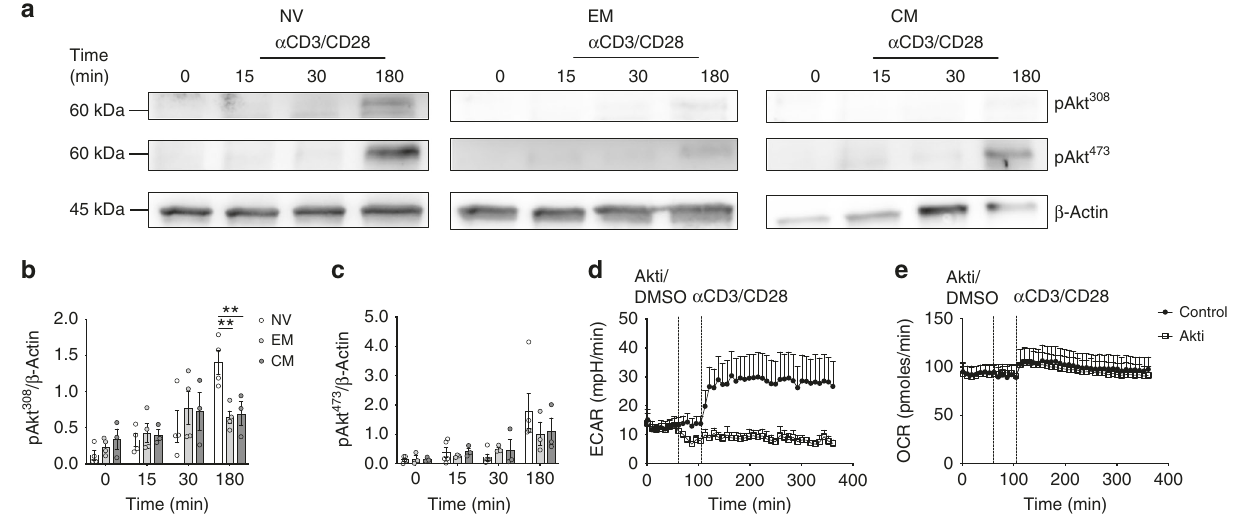
Fig. 4 Early T-cell activation requires Akt phosphorylation. a Immunoblot for pAkt Thr308 and Ser473 and β -actin in NV, EM and CM T-cells following 0, 15, 30 and 180 min of activation with anti-CD3/CD28. Densitometry of pAkt Thr308 ( b ) and pAkt Ser473 ( c ) for NV, EM and CM T-cells normalised to β - actin. ECAR ( d ) and OCR ( e ) in NV CD4 + T-cell upon treatment with either 10 μ M Akt1/2 kinase inhibitor or vehicle control (DMSO) and anti-CD3/CD28 at the times indicated. Data are representative ( a – c ) of 3 – 5 experiments with one representative immunoblot sample of 3 – 5 is shown, ( d , e ) three experiments. Statistical analysis was performed using a nonmatching two-way ANOVA with Sidak ’ s multiple comparison test ( b , c ). Data are expressed as mean ± SEM; ** p ≤ (Fig. 6d). The presence of the m + 5 mass isotopologue (14%) in the metabolite pool of citrate indicates that reductive decarbox- ylation of α -ketoglutarate to citrate is also taking place. The reductive decarboxylation) was abolished by STAT5 inhibition.